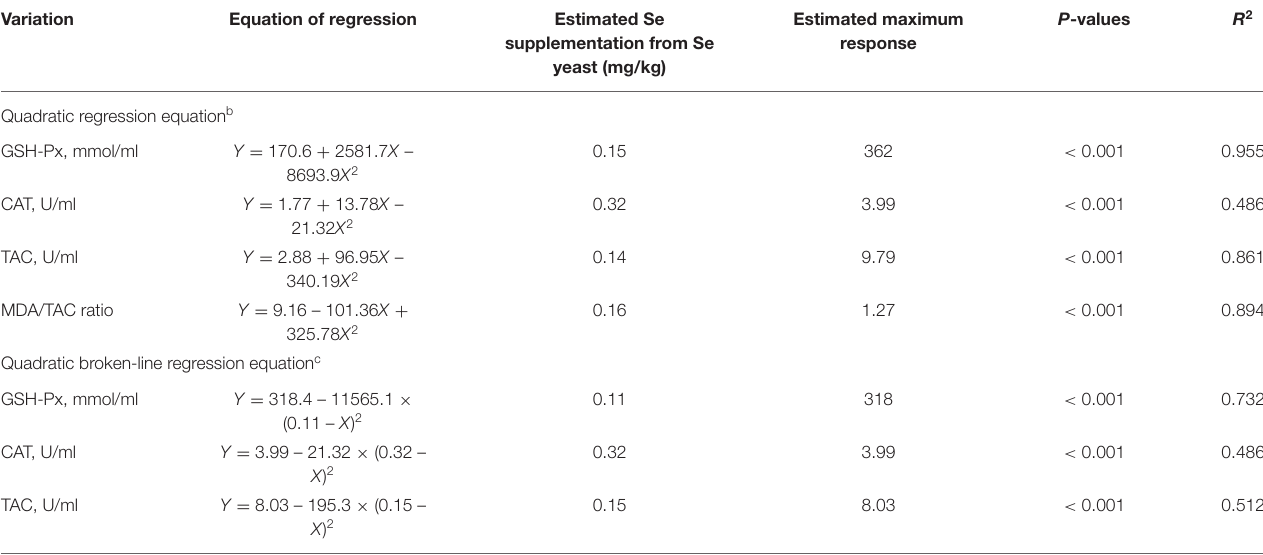
Variation Equation of regression Estimated Se